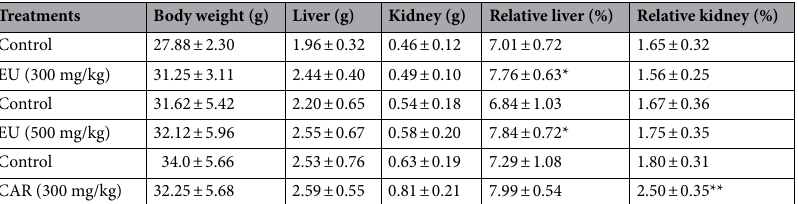
Table 5. Total mouse body weights, quantitative organ weights (g), and relative organ weights (%) of the liver and kidneys in control and EU- or CAR-treated mice. * and **: significantly different from the corresponding controls at P < 0.05 and P < 0.001 levels,